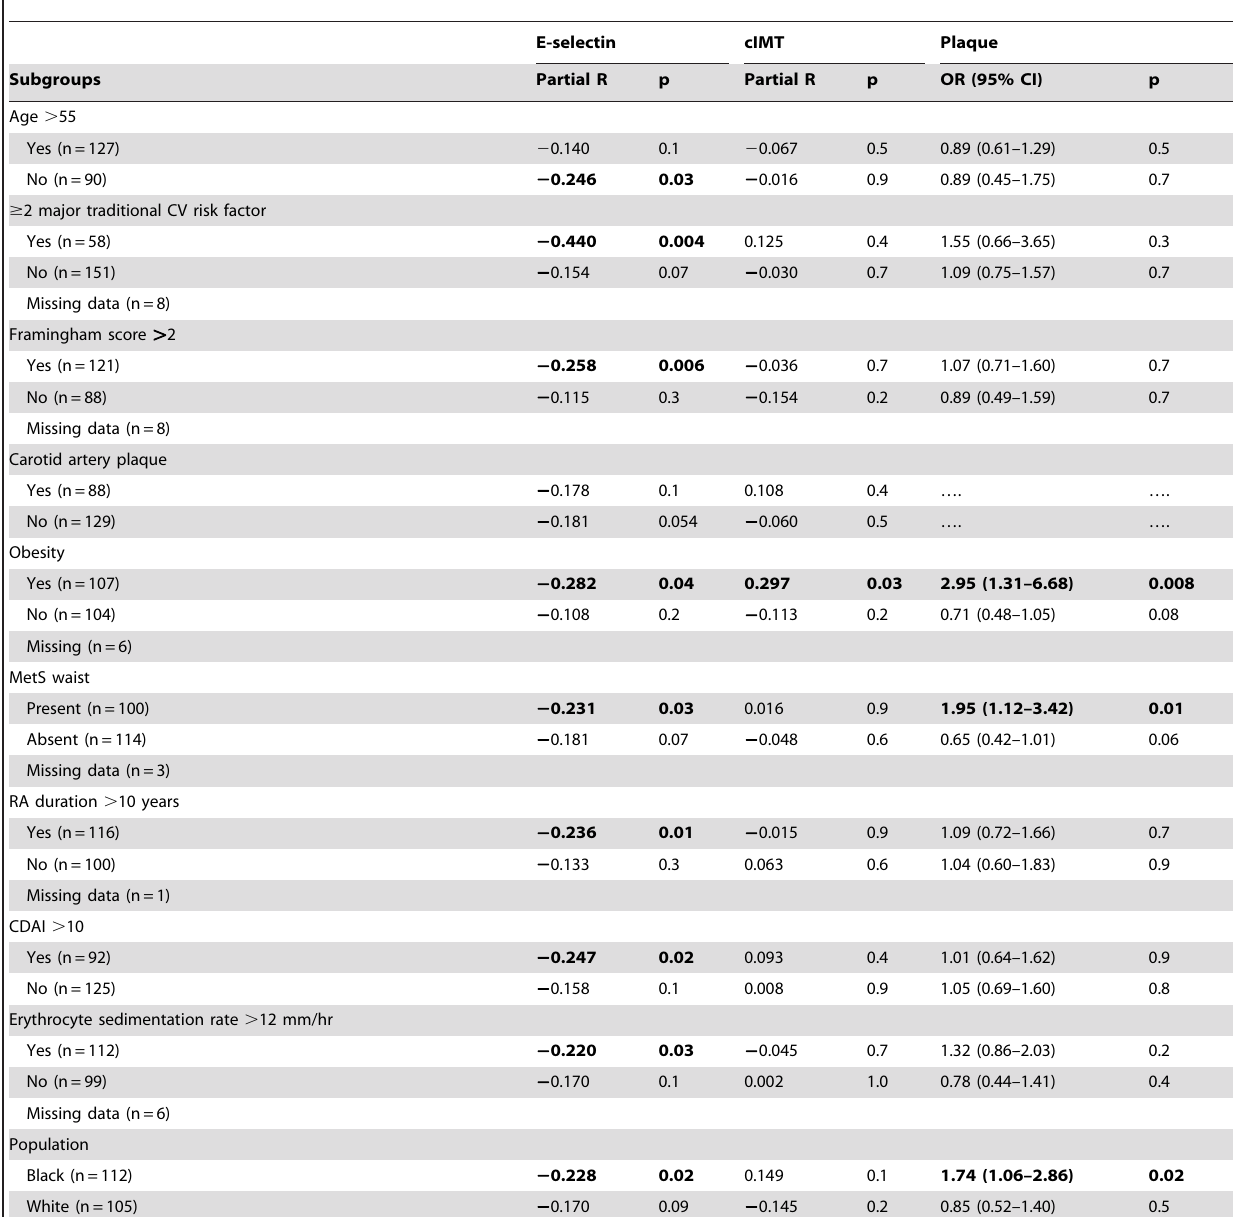
Table 6. Independent relationships of retinol binding protein 4 concentrations with those of E-selectin and atherosclerosis amongst